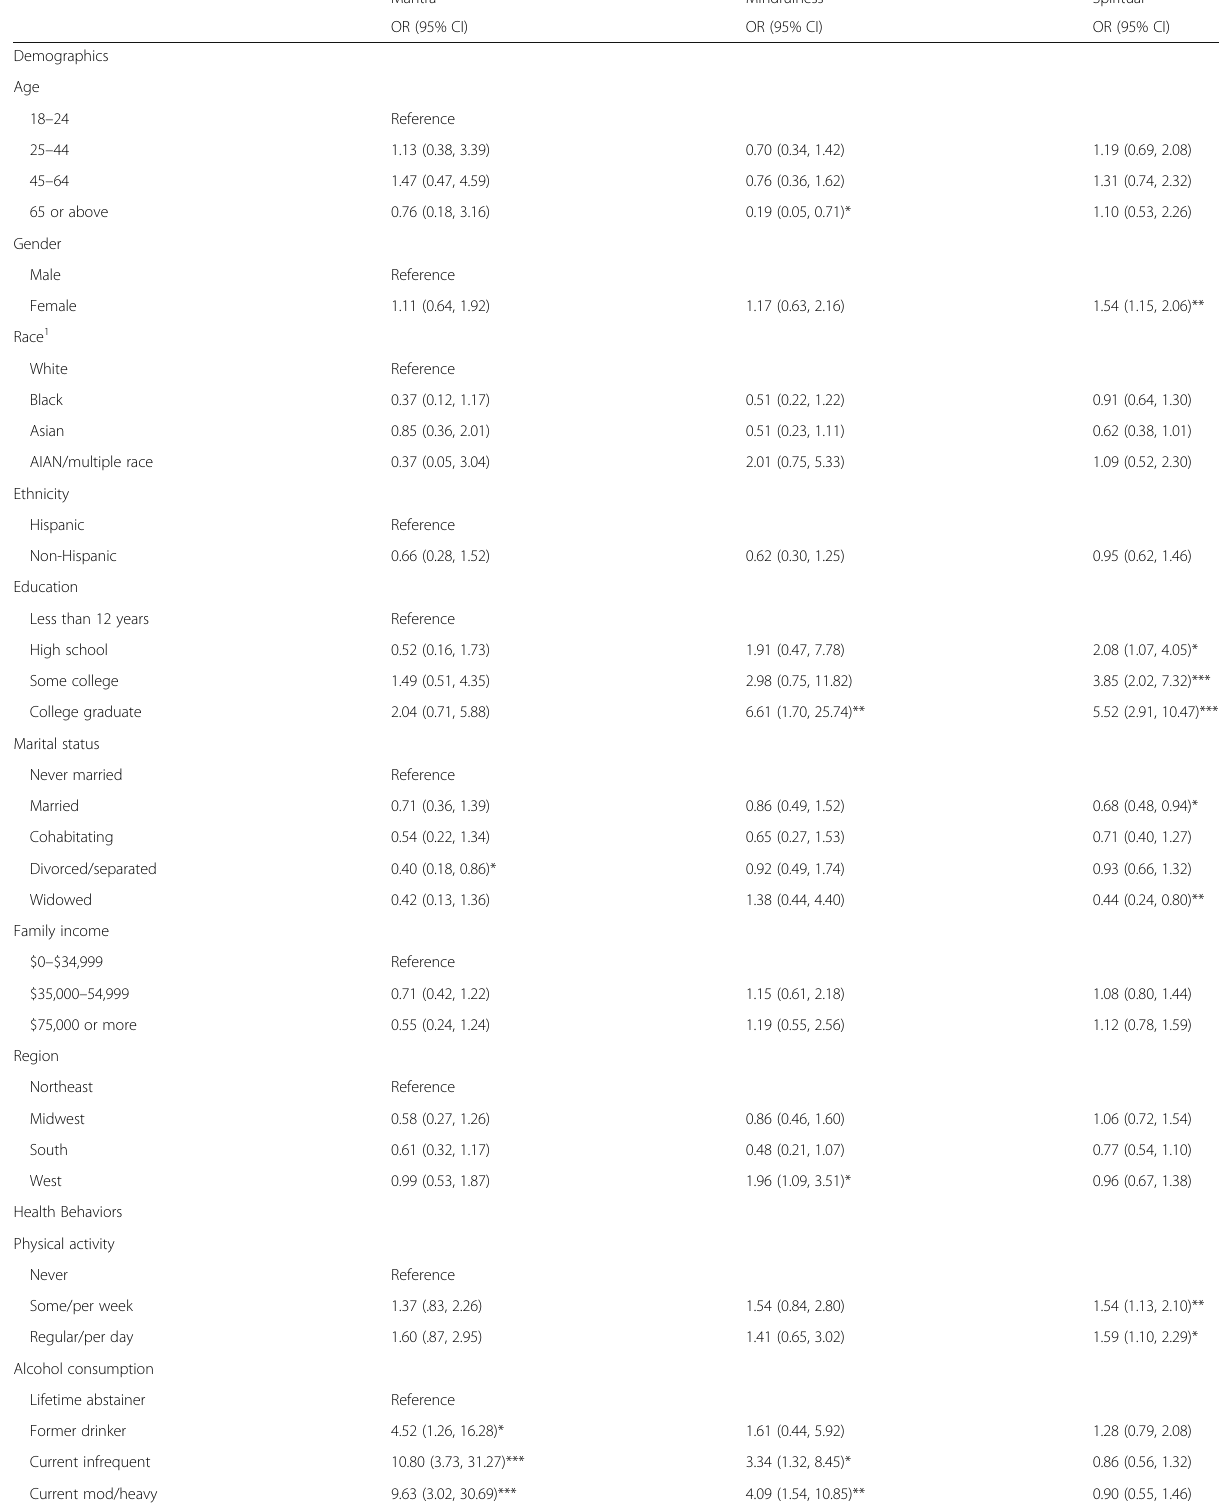
Table 3 Multivariable logistic regression predicting meditation practices, exclusive use of one meditation style during the